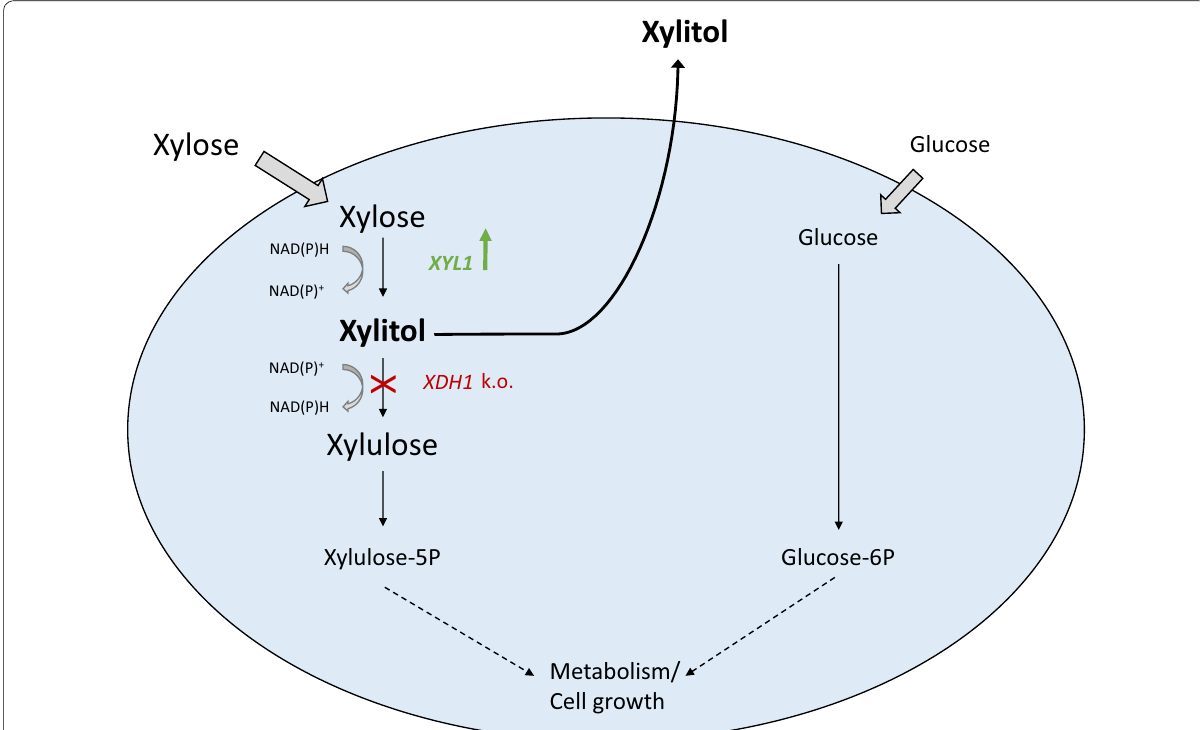
Fig. 1 Illustration of xylose metabolism pathway. Xylose metabolism (part) of xylose-utilizing non-conventional yeasts (suggested in (da Silva et al. 2005)) Xylose metabolizing enzymes covered in this study are highlighted in green ( XYL1